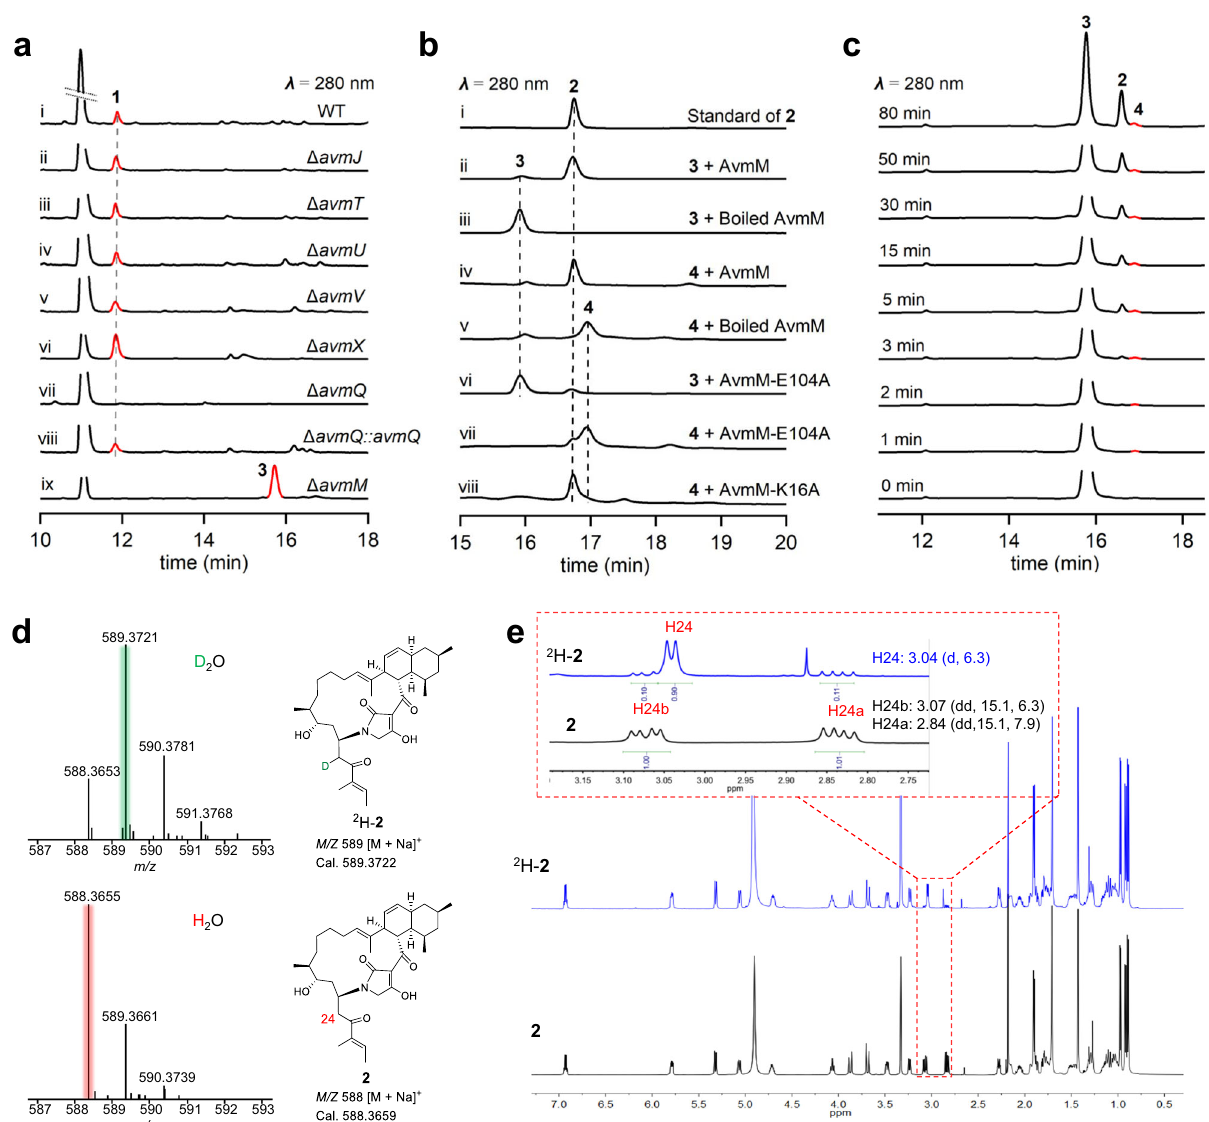
Fig. 2 | Characterization of AvmM as a macrocyclase. a HPLC analysis of meta- bolicextractsfrom S .sp.TP-A0867wild-typeandmutantstrains. b Invitroenzyme assays of 3 or 4 incubated with the wild-type or mutant AvmM constructs. The conversionratesfrom 3 or 4 to 2 areasfollow: ii)~90%; iii) 0%; iv) ~100%;v) 0%;vi)